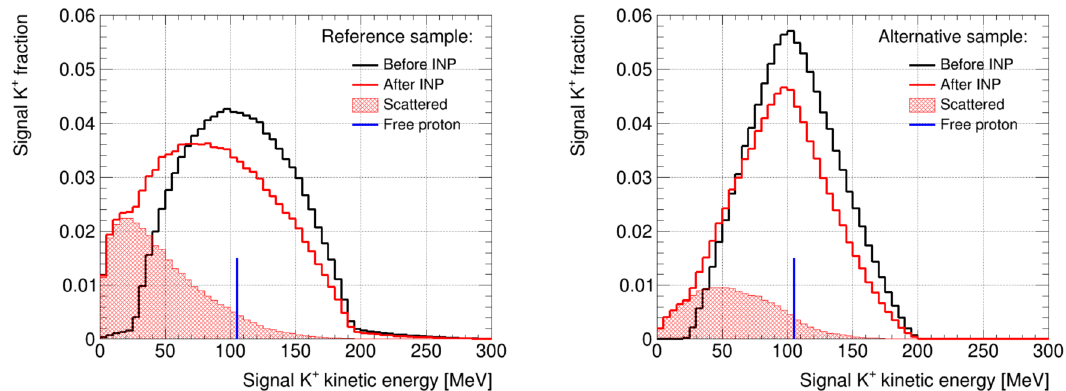
Figure 1 . Signal K + kinetic energy distributions before and after intranuclear propagation (INP) for the reference (left) and alternative (right) samples. All distributions are normalized to their respective sample size before INP, and the simulation of charge-exchange in the alternative sample results in a signal K + loss of 15 % after INP. The vertical blue line at 105 . 3 MeV indicates the K + kinetic energy from the decay of a free proton at